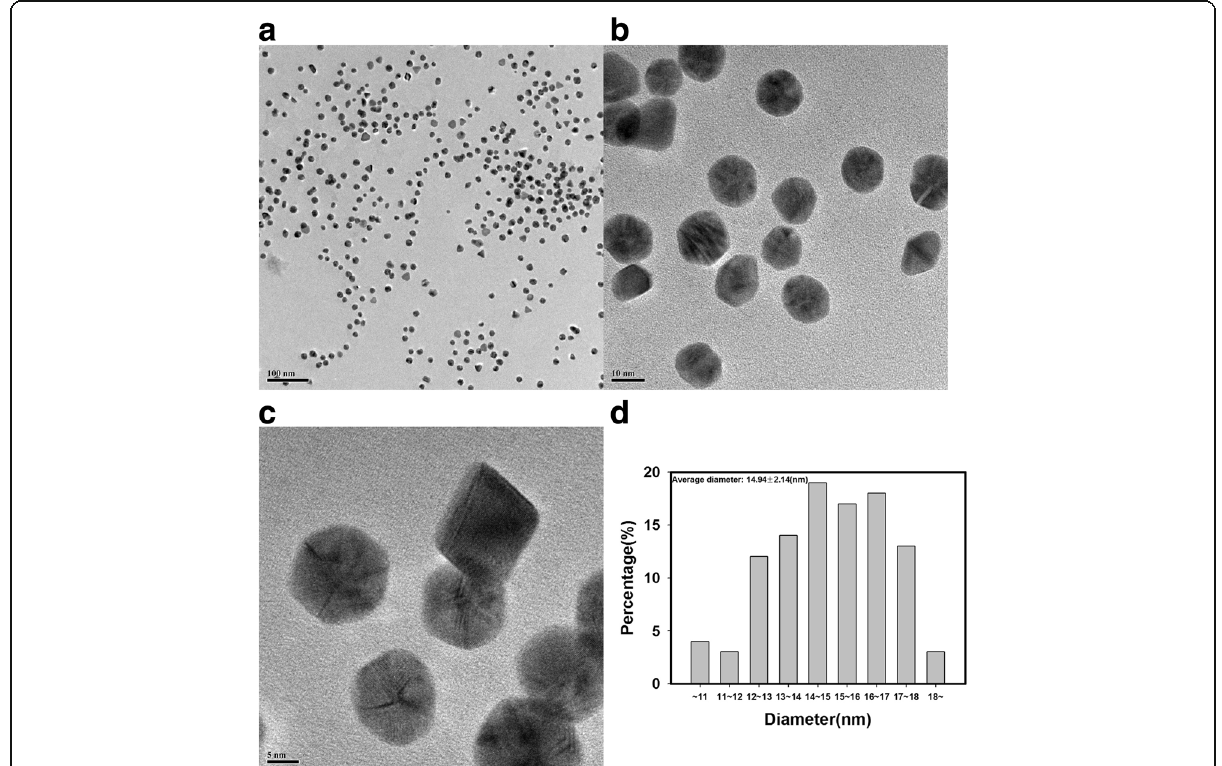
Fig. 3 a – c HR-TEM images and d a size histogram of PD-AuNPs. The scale bars represent a 100 nm, b 10 nm, and c 5